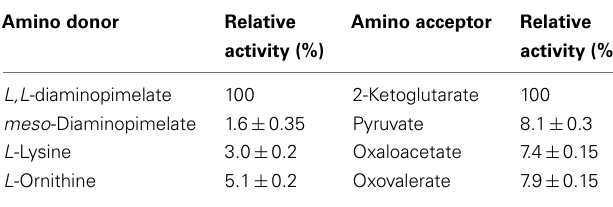
Table 2 |Activity of Vs DapL with various amino donors and amino acceptors.